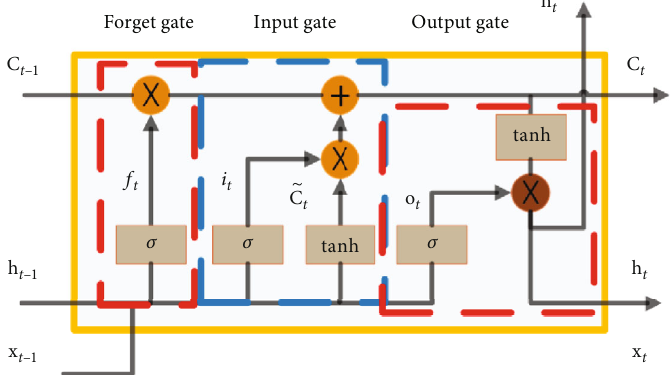
Figure. 5: Long Short-Term Memory (LSTM) unit.